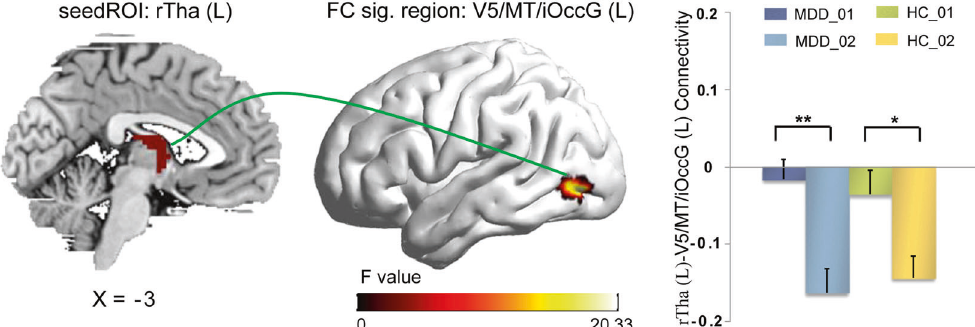
Fig. 3 Main effect of BMRM. BMRM had the same effect on the healthy controls and MDD patients in the functional connectivity between the left rostral temporal thalamus (rTtha) and the left V5/MT + /inferior occipital gyrus (iOccG). Decreased FC values were observed after the BMRM in both groups. BMRM body-mind relaxation meditation, L left, R right. *0.01 ≤ p < 0.05, **0.001 ≤ p ≤ 0.01, *** p < 0.001.